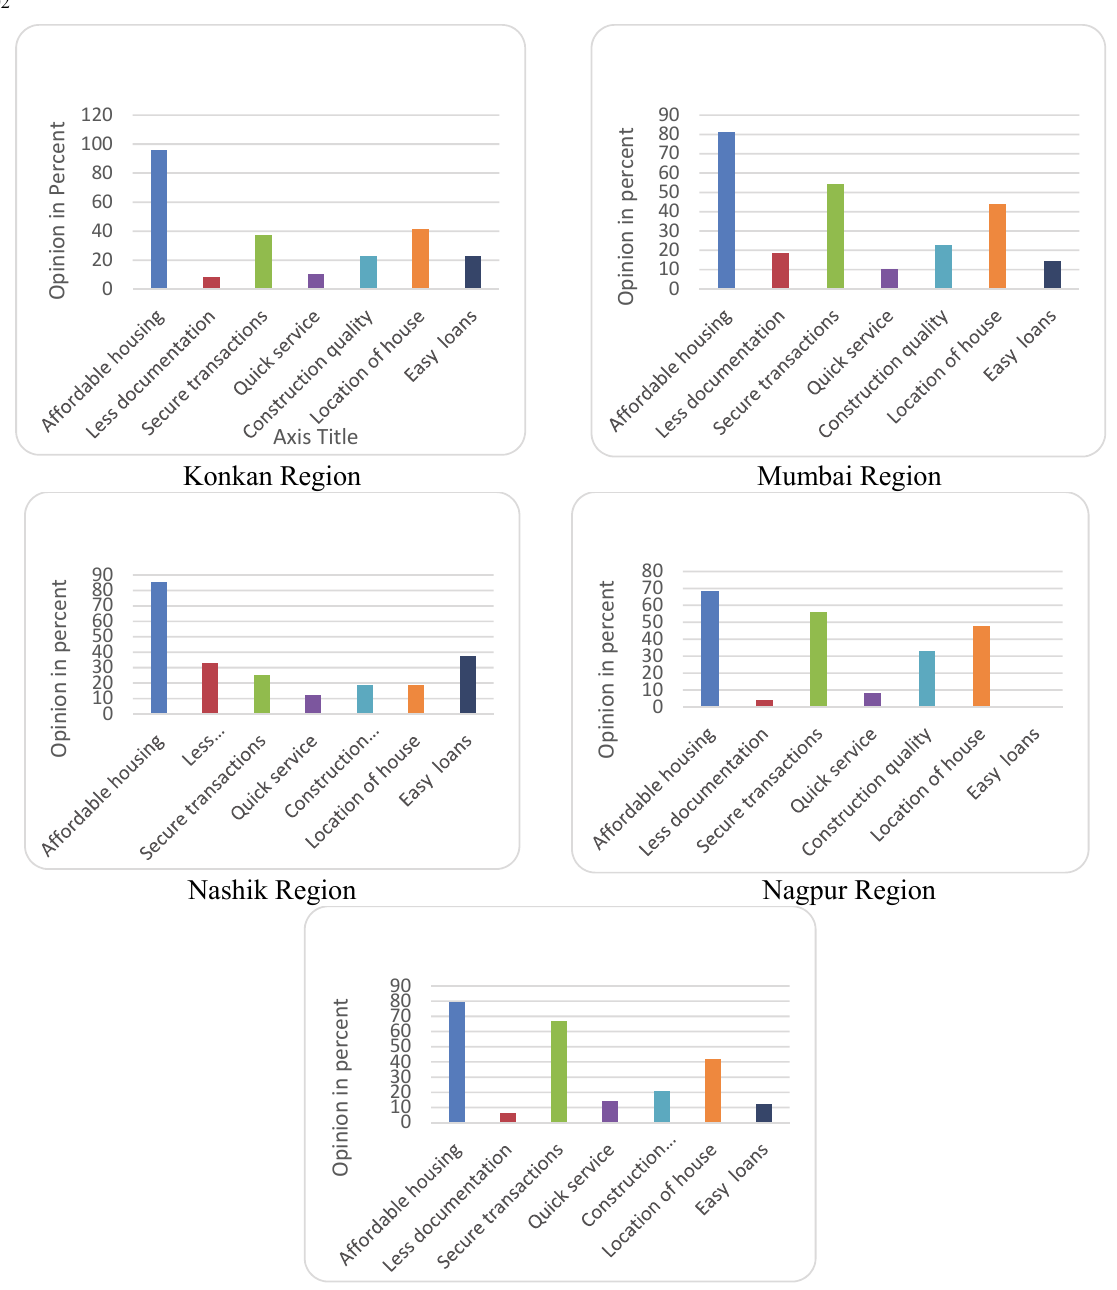
Fig. 3. Factors influencing purchase of housing from